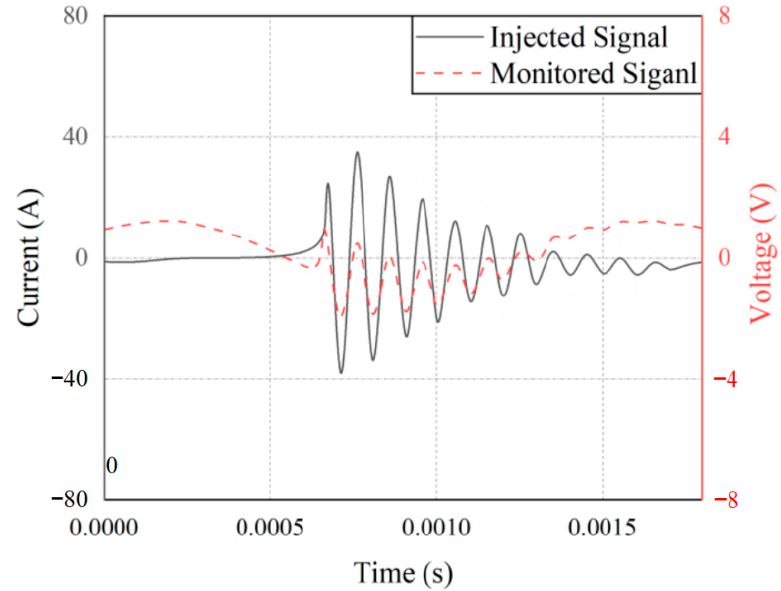
Figure 12. The terminal conditioning circuit of the speed signal cable.